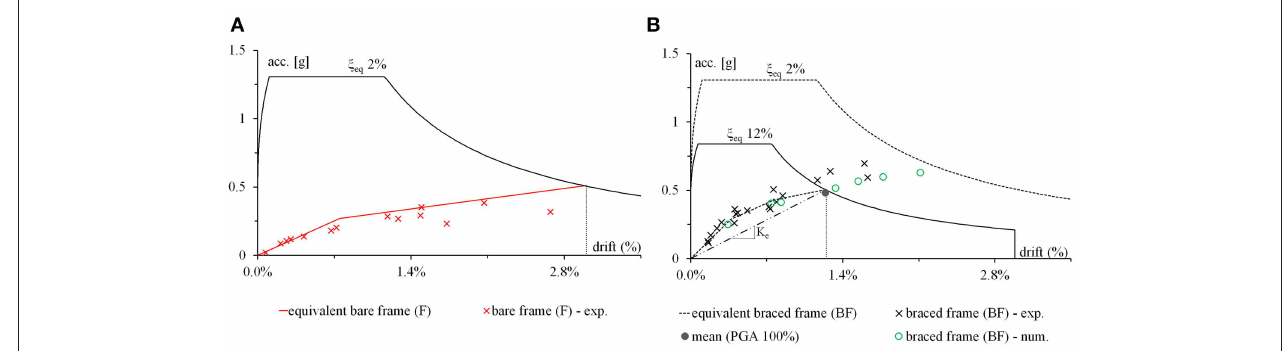
FIGURE 13 | Comparison between design results and experimental peak values in (A) free-rocking configuration and (B) dissipative bracing configuration of Pres-Lam experimental model.